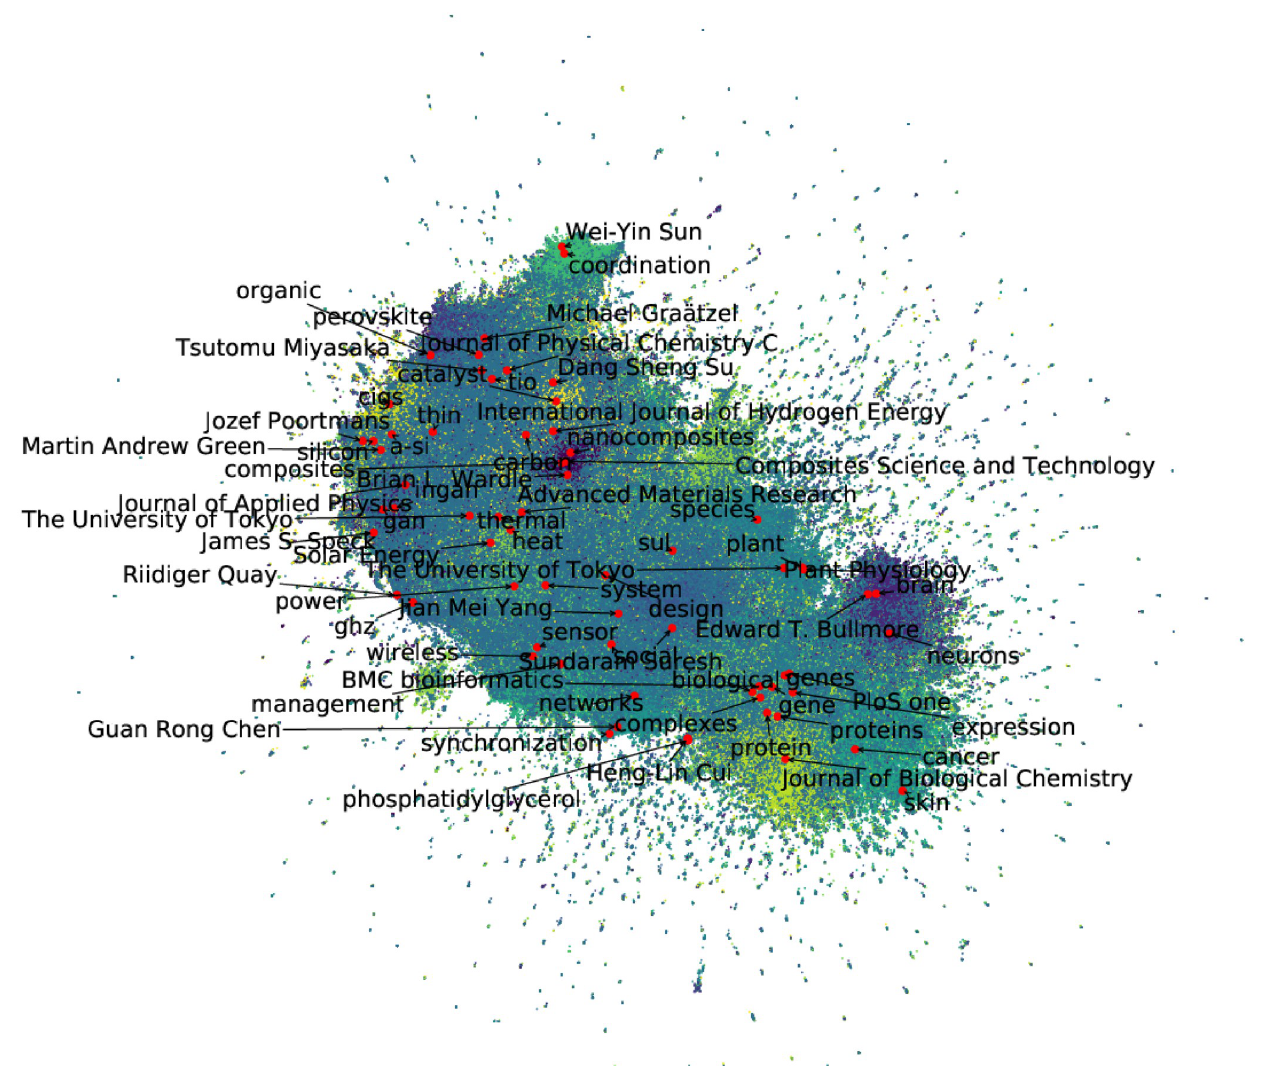
Fig 4. UMAP visualization of acquired distributed representation (color-coded results obtained using K-means